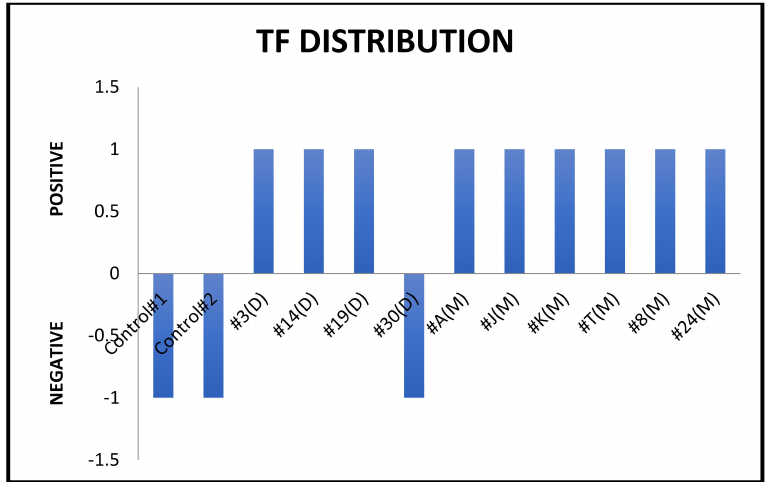
Figure 2. Radiographic presentation of an eight-year-old with a history of GSD type Ib. Radiographic examination reveals severe horizontal bone loss involving the remaining primary dentition.